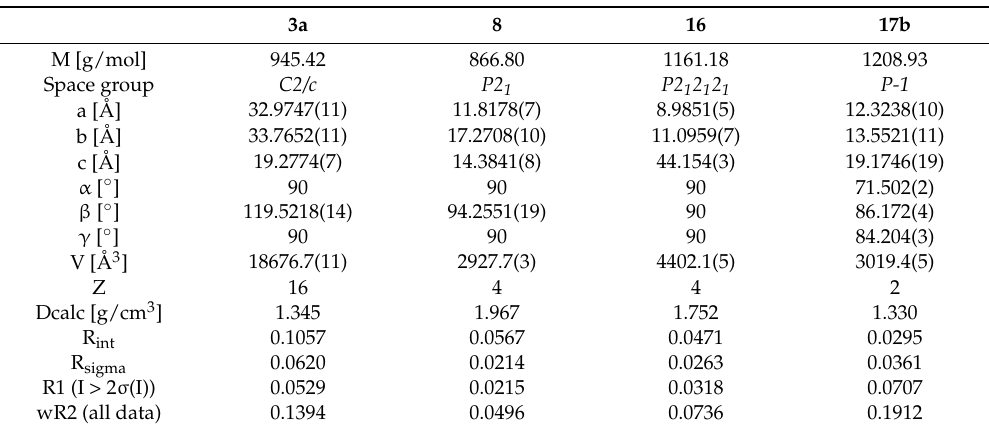
Table 1. Crystal data for 3a , 8 , 16 , and 17b